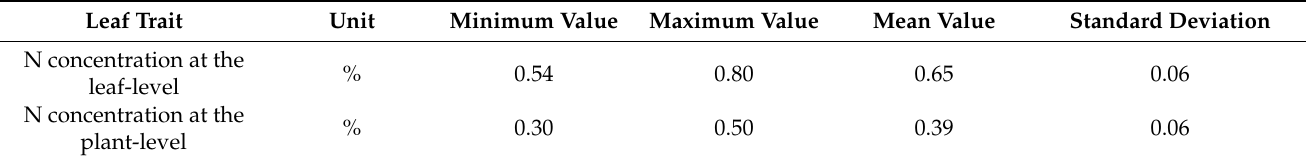
Table 2. Mean, minimum, maximum, and standard deviation values calculated for N concentrations at the leaf- and